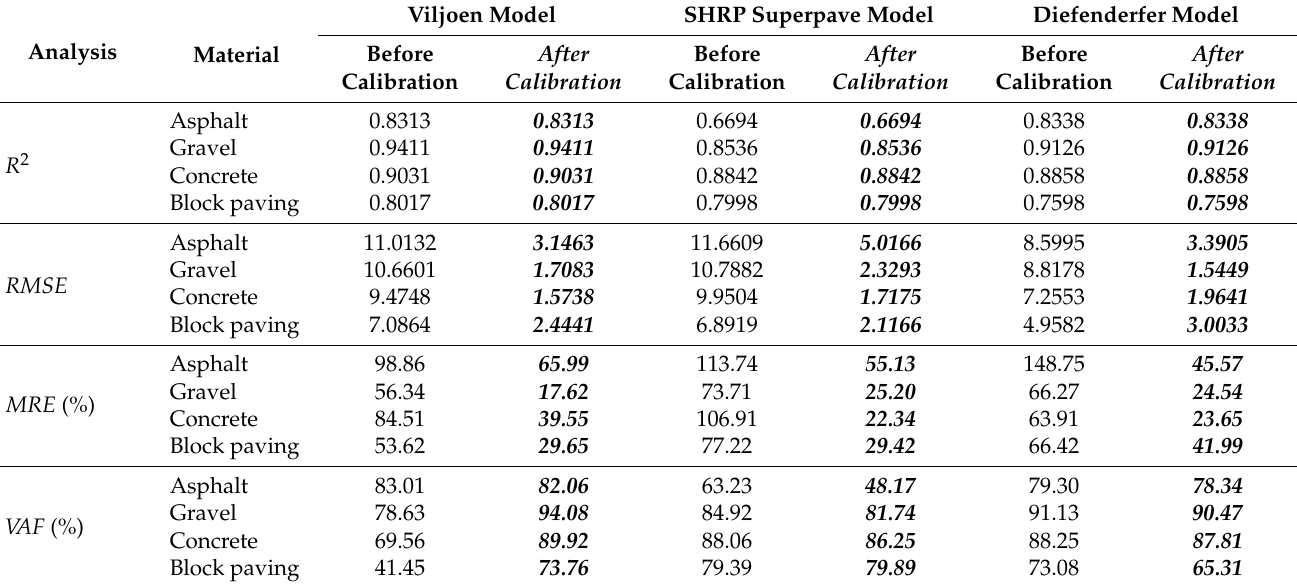
Table 1. Analysis of uncalibrated and calibrated predicted maximum temperatures.